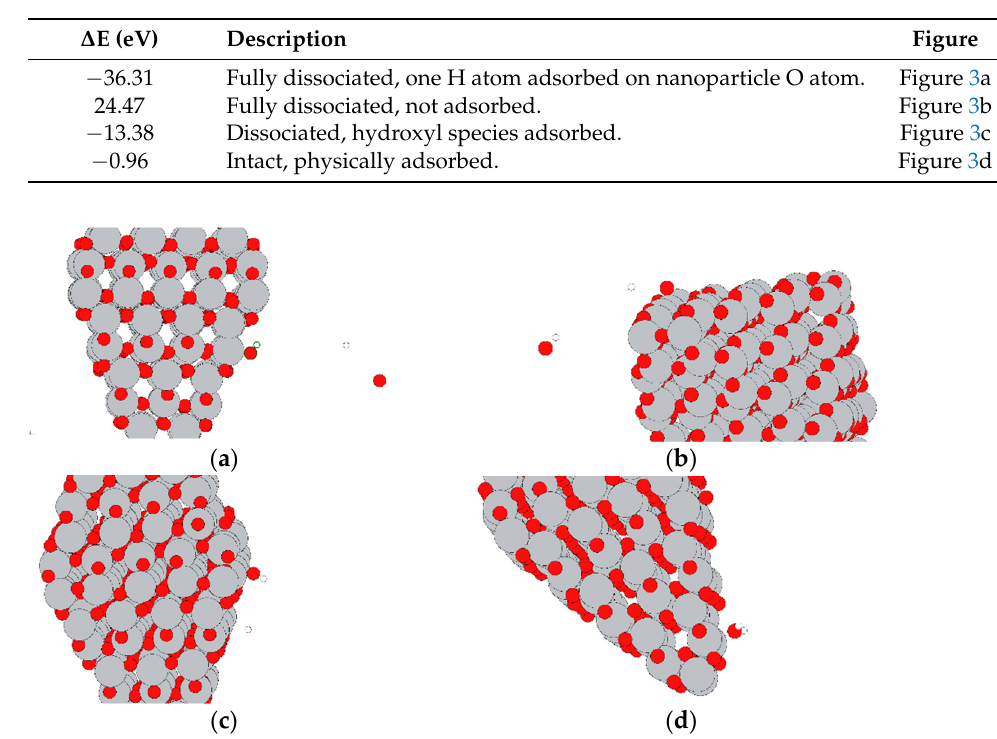
Figure 2. Energies of interaction for all water molecules in the nanoparticle system. The x-axis corresponds to the molecular ID of the water oxygen atoms. Table 2. Indicative water–nanoparticle interaction energies.